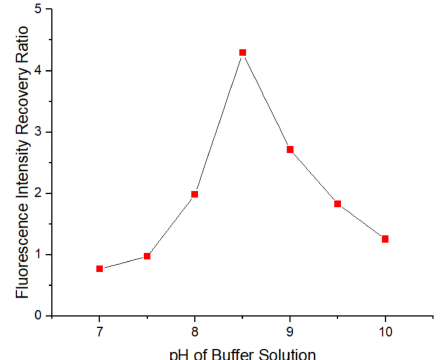
Figure 6. The relationship between the fluorescence intensity recovery ratio and the pH of Tris-HCl bu ff er solution. Concentration of Tris-HCl bu ff er solution: 10 mmol / L. Concentration of added QD solution: 5 µ mol / L. Concentration of added APDC solution: 100 µ mol / L. Concentration of